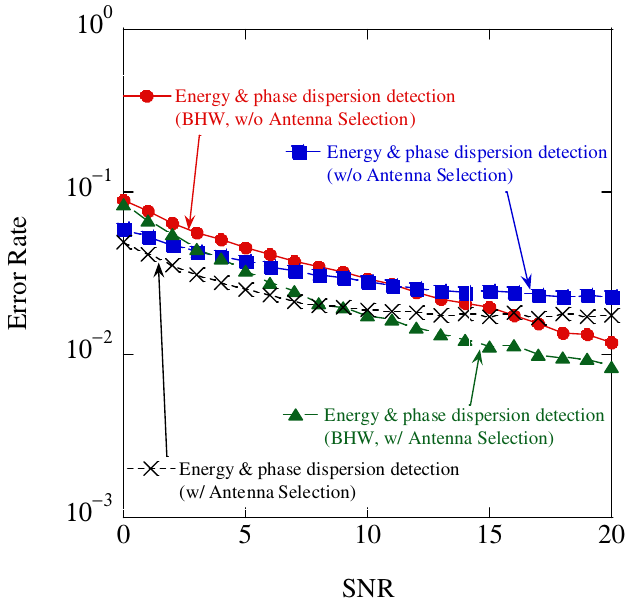
Figure 15. Aggregate accuracy results.